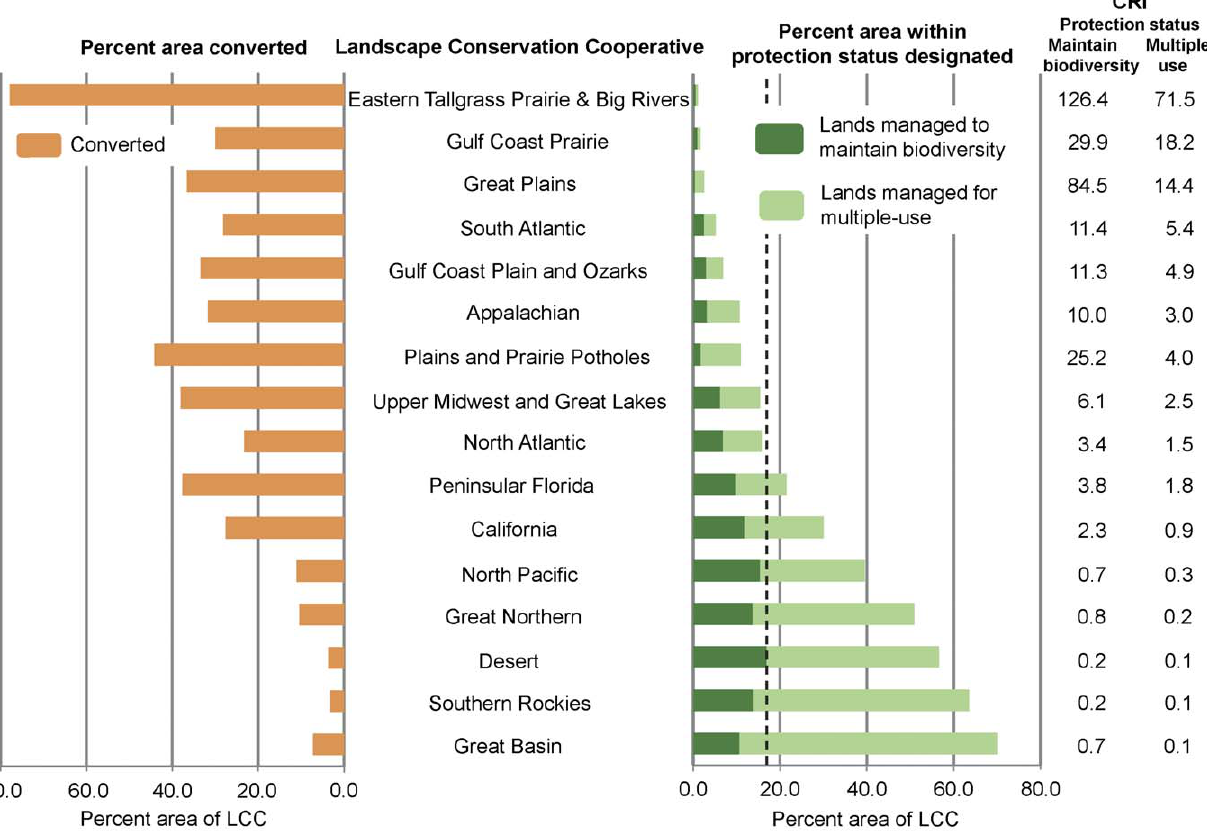
Figure 8. Percent area of Landscape Conservation Cooperative (LCC) protected or converted and its conversion risk index (CRI). CRI for each LCC is calculated by dividing percent area converted by percent area protected [62]. The CRI index is shown for lands managed to maintain biodiversity (i.e., labeled maintain biodiversity) as well as for lands managed to maintain biodiversity and multiple-use (i.e., labeled multiple-use) [23]. The LCCs are ordered by percent area within each protection status. See Table 1 for protection status descriptions. A dashed line representing the 17% Aichi Biodiversity Target of the Convention on Biological Diversity is shown [36].